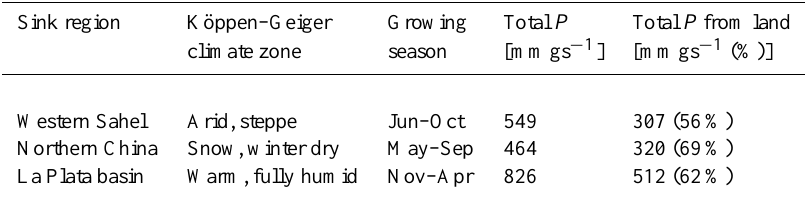
Table 1. Characteristics of sink regions ( P is precipitation, and gs is growing season). “Total P ” refers to the 32-year mean precipitation (in mm) during the growing